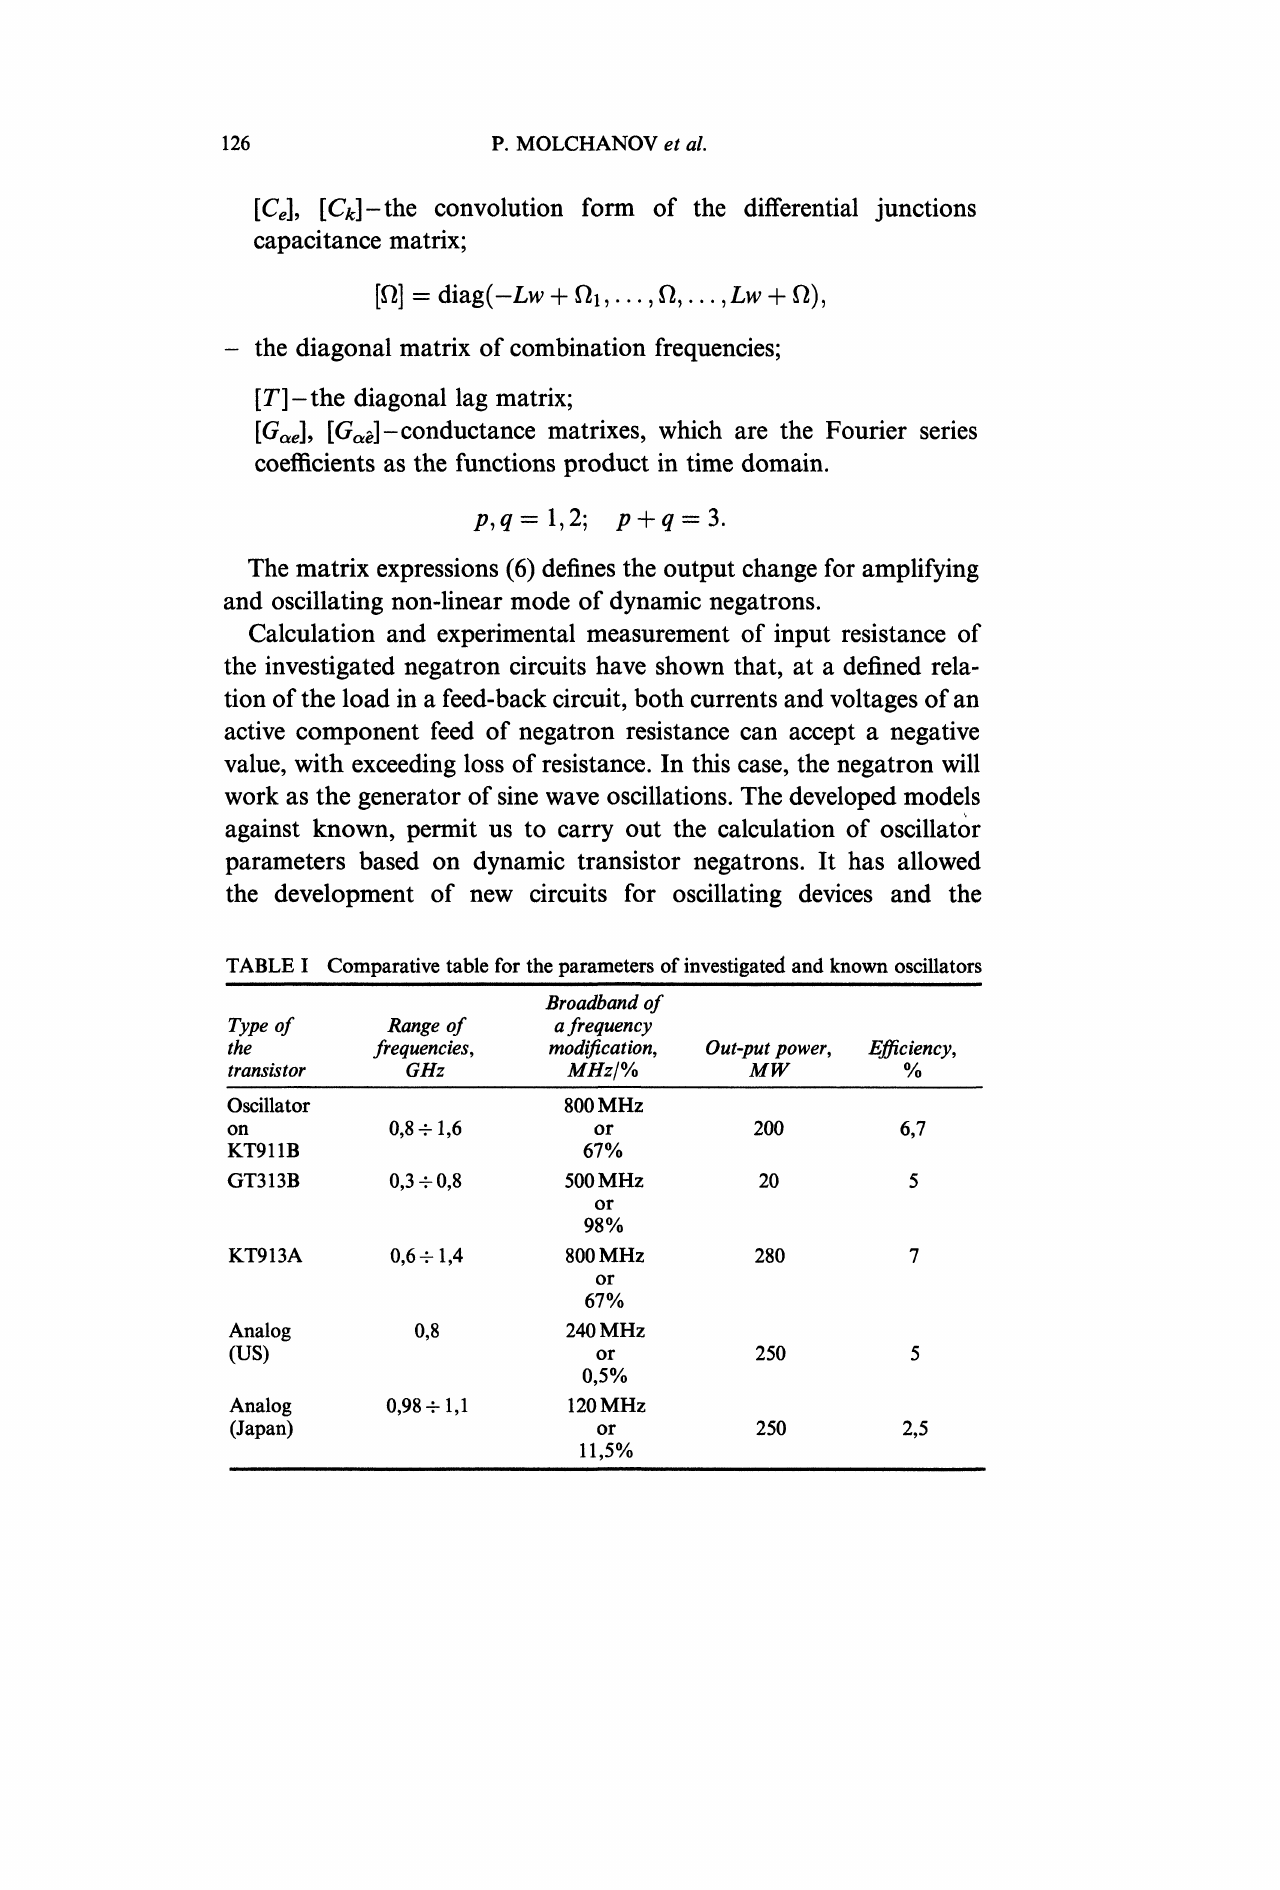
Comparative table for the parameters of investigated and known oscillators Broadband of Type of Range of a frequency